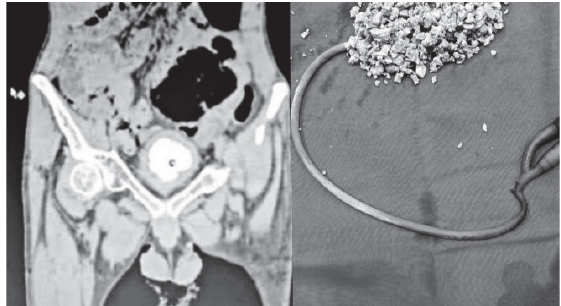
Figure 3. CT shows rounded stone around the tip and balloon of catheter (A); Foley’s catheter with fragmented stones around the tip